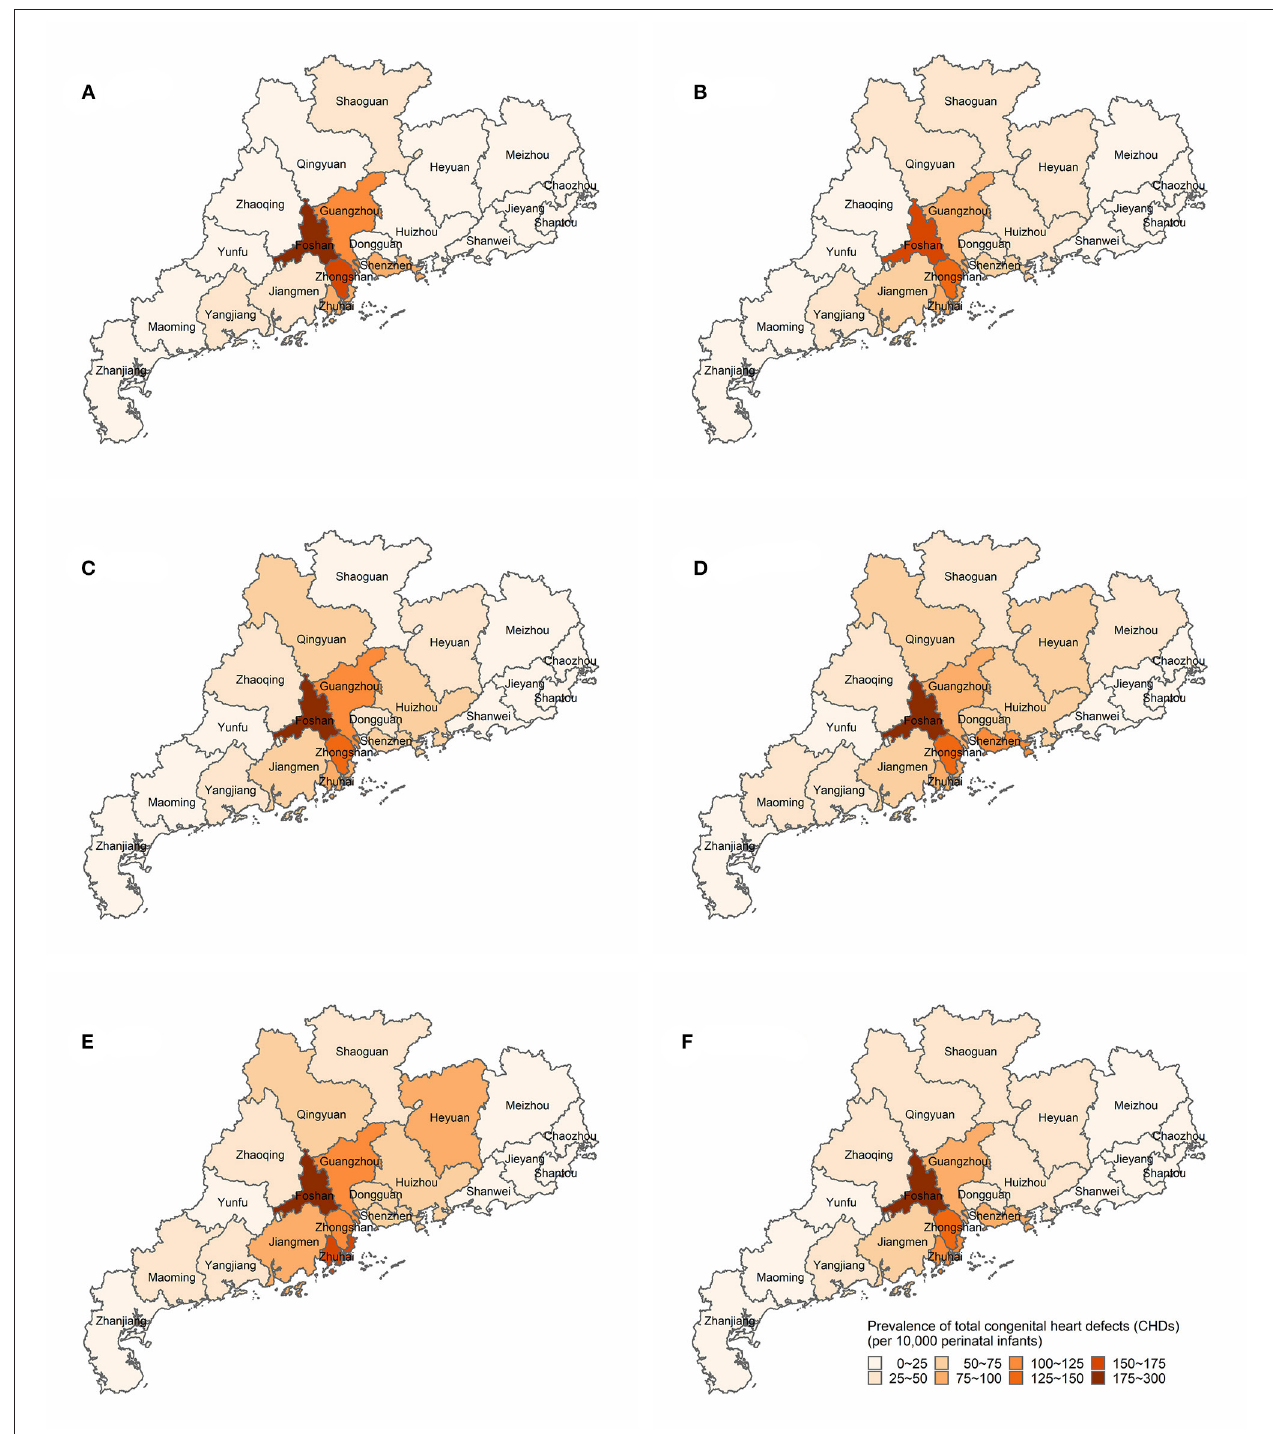
FIGURE 3 | Spatial distributions of the prevalence of total congenital heart defects (CHDs) (per 10,000 perinatal infants) in Guangdong, China, 2016–2020. (A) Spatial distributions of total CHDs prevalence in 2016. (B) Spatial distributions of total CHDs prevalence in 2017. (C) Spatial distributions of total CHDs prevalence in 2018. (D) Spatial distributions of total CHDs prevalence in 2019. (E) Spatial distributions of total CHDs prevalence in 2020. (F) Spatial distributions of total CHDs prevalence in 2016–2020.